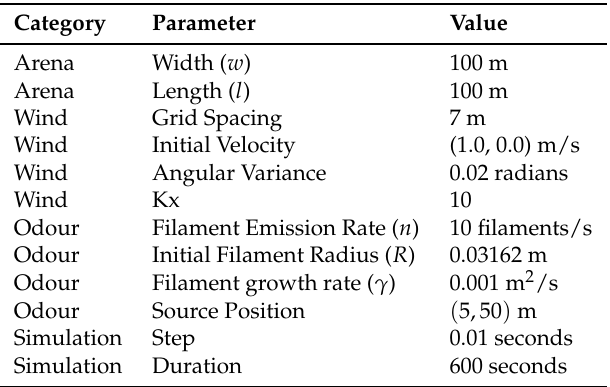
Table 5. Parameters used for validating the